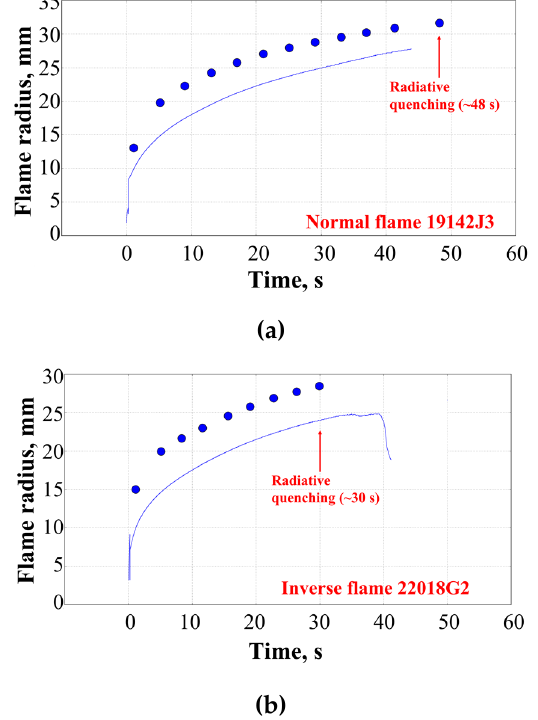
(b) Figure 2. Photographs of the spherical diffusion flames of ethylene in the Flame Design (Adamant) SE under microgravity conditions on the ISS: ( a ) sooty normal flame; ( b ) sooty inverse flame [42,43]. Figures 3 and 4 show examples of the measured and calculated time histories of the flame radius and temperature for normal and inverse flames, which undergo radiative extinction ~48 and ~30 s after ignition, respectively. The symbols correspond to the exper- iment, and the curves correspond to the calculation according to the model described above. Figure 3 shows that both the normal and inverse flames slowly move away from